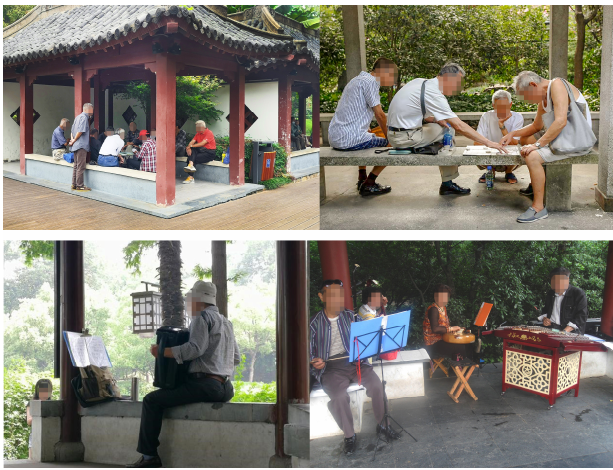
Figure 6. Older adults engaging various activities in amenity buildings.